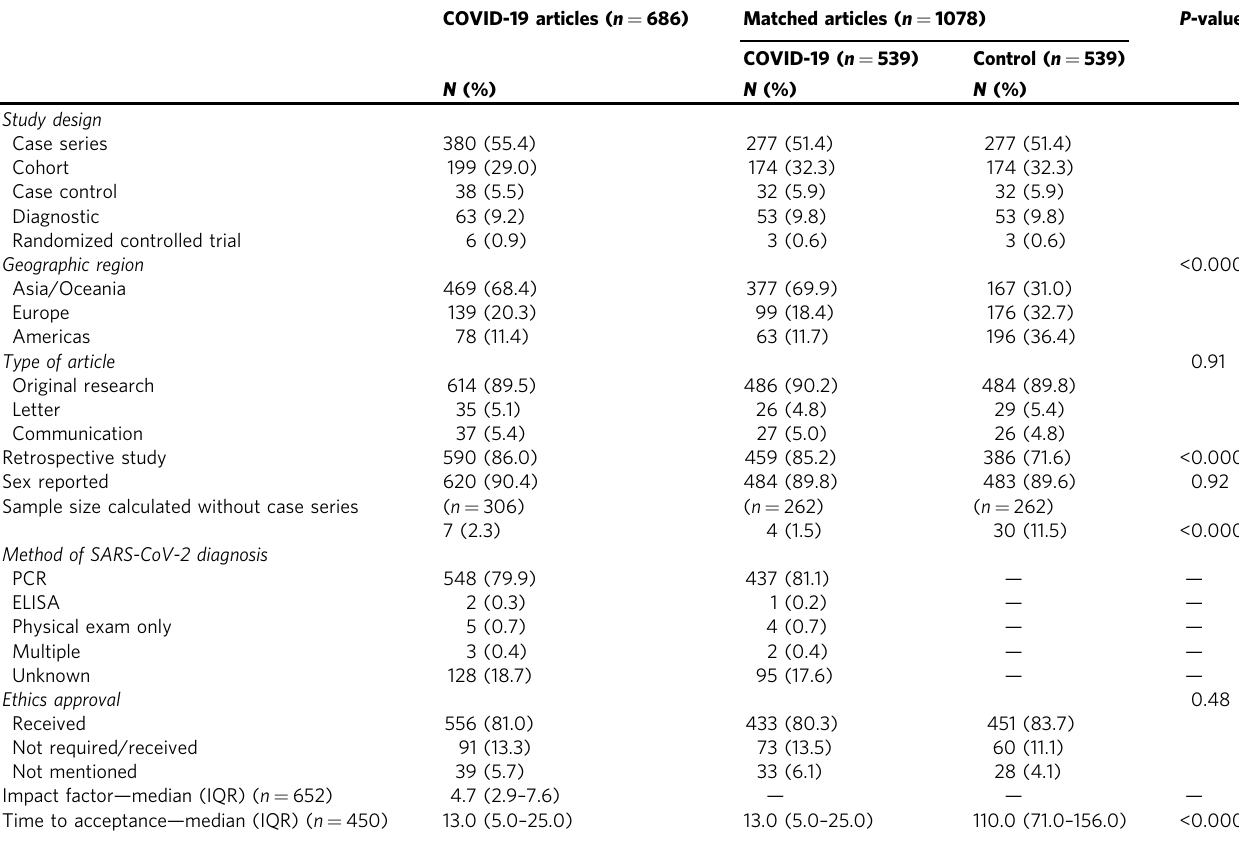
Table 1 Characteristics of COVID-19 clinical literature until May 14,